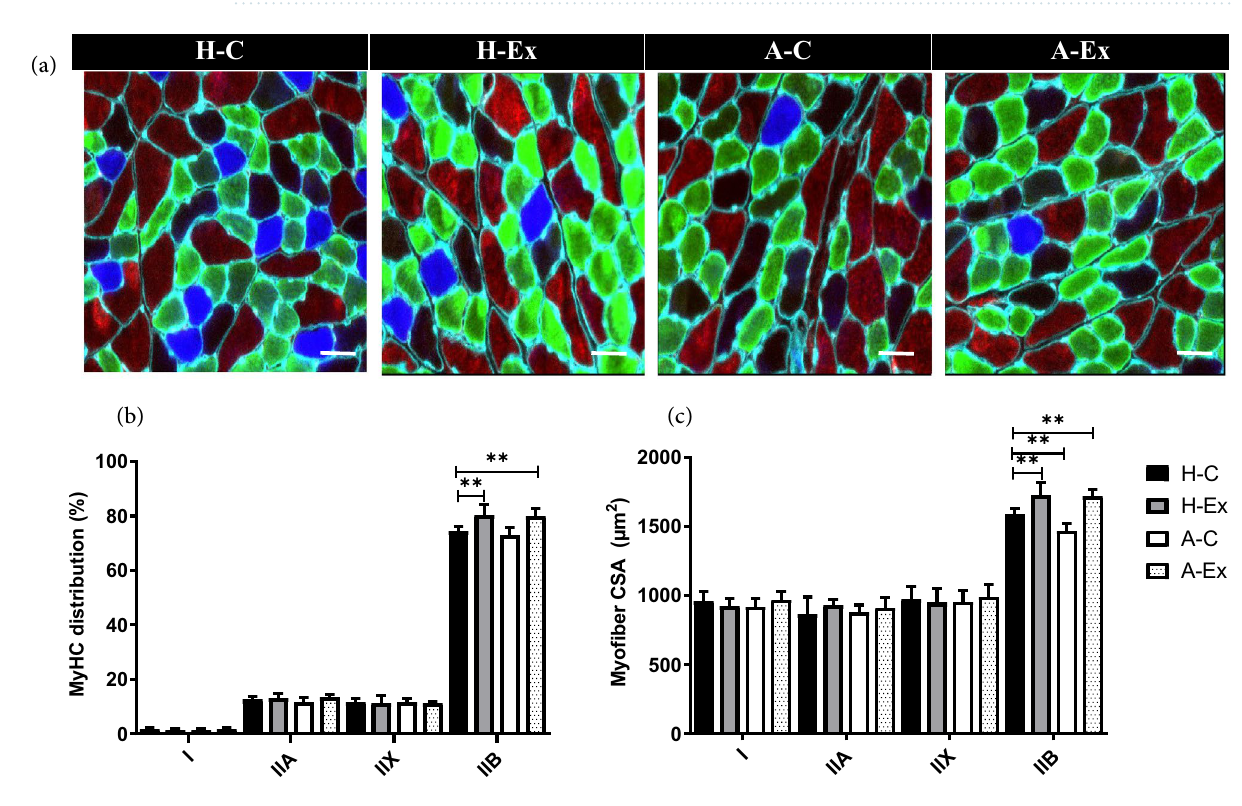
Figure 5. Muscle fiber satellite cell in different experimental groups. ( a 1–4) Section of gastrocnemius muscle immunolabeled for Laminin (red), Pax7 + (green), and Hoechst (blue). ( b ) Number of Pax7 + /100 fibers. Image analysis was performed using MyoView software 7 . Scale bar = 50 µm. ** p < 0.001.